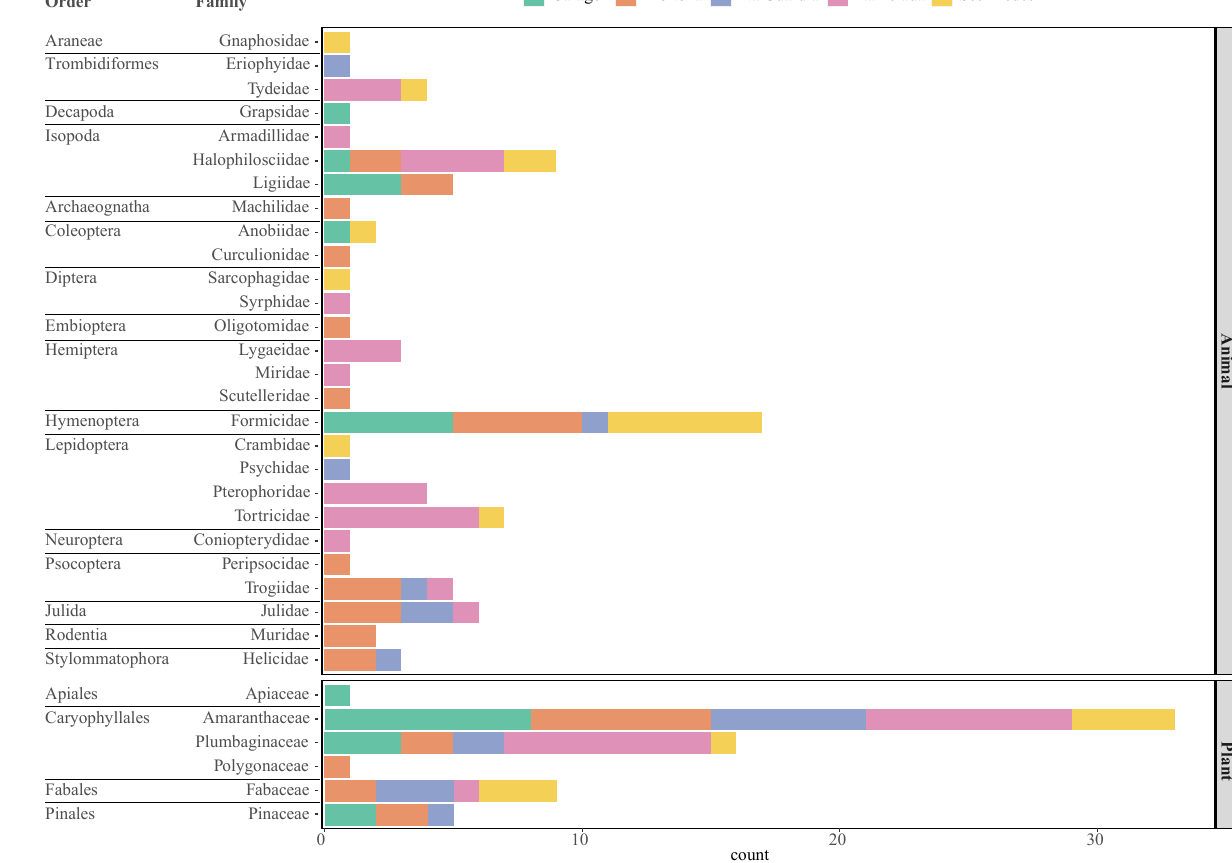
Figure 3. Percentage of occurrence of each family of animals or plants in the diet composition of Podarcis lilfordi through molecular analysis. All populations pooled.